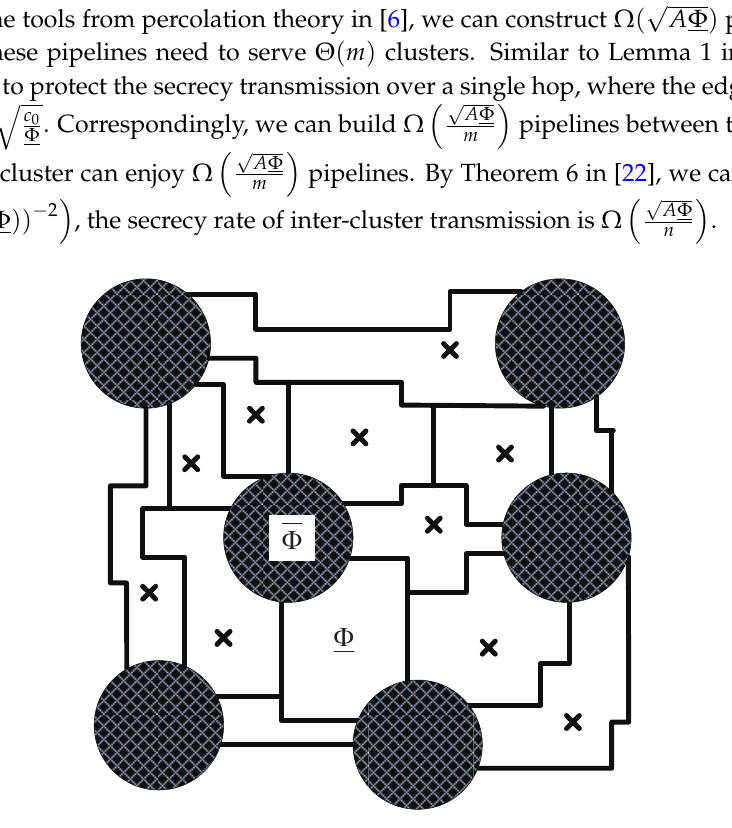
Figure 5. An illustration of information pipelines among clusters. Since the minimum node density